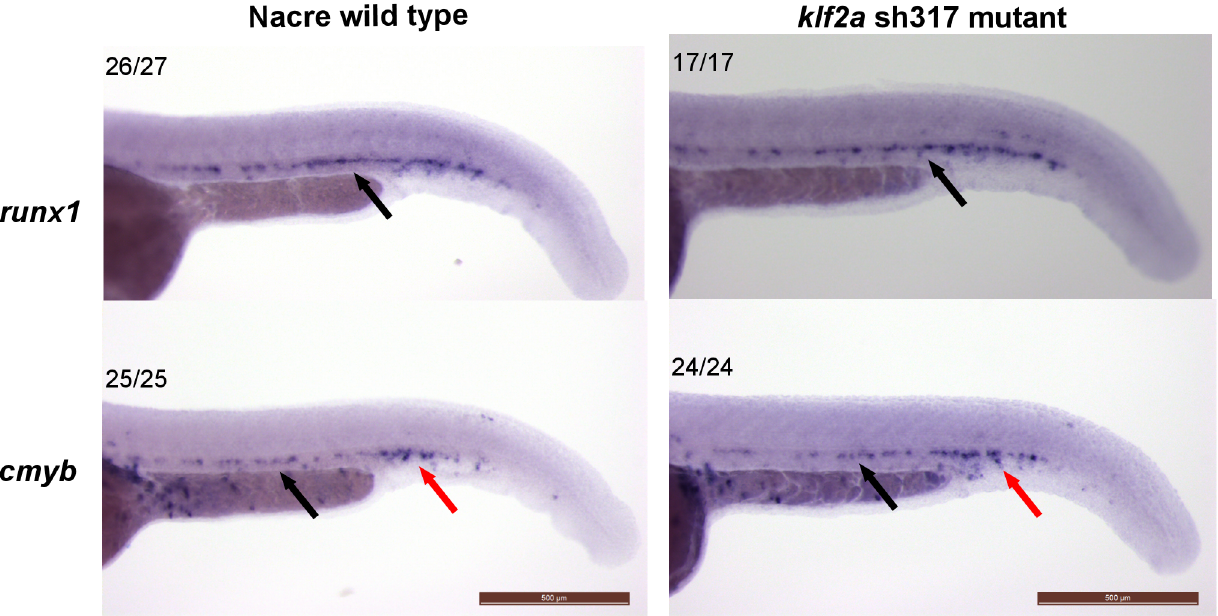
Fig 7. Expression of HSC markers runx1 and cmyb is unaffected in homozygous klf2a sh317 mutants at 36hpf. Expression patterns of HSC markers runx1 (top panel) and cmyb (bottom panel) do not differ between the wildtype and klf2a sh317 mutants at 36hpf. Black arrows indicate the aorta-gonad- mesonephros (AGM) region and red arrows indicate caudal haematopoietic tissue (CHT). Numbers in the top left corners indicate number of embryos with similar staining patterns out of total number of embryos examined. Scale bar = 500 μ